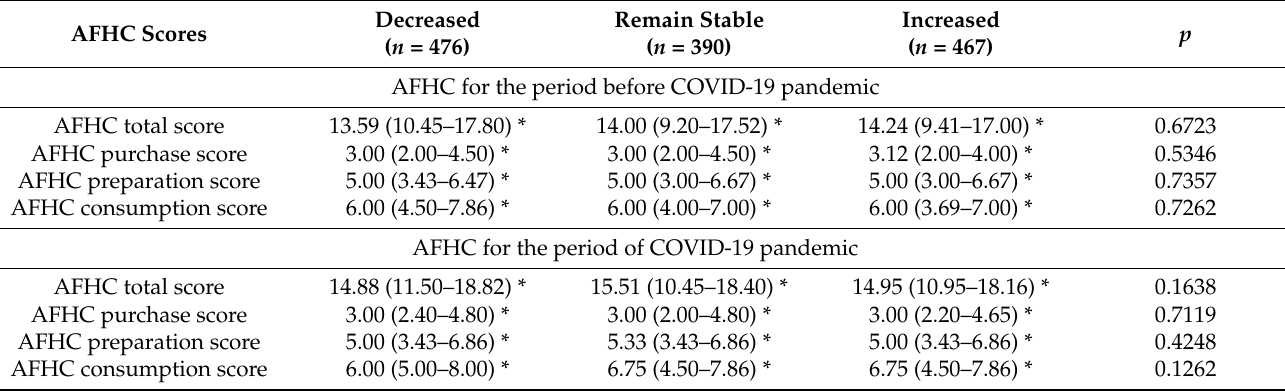
Table 6. The Adolescents’ Food Habits Checklist (AFHC) scores for the period before the COVID-19 pandemic and for the period of COVID-19 pandemic, stratified by physical activity changes during the COVID-19 pandemic, for the total population of adolescents from the Diet and Activity of Youth during COVID-19 (DAY-19) Study ( n =